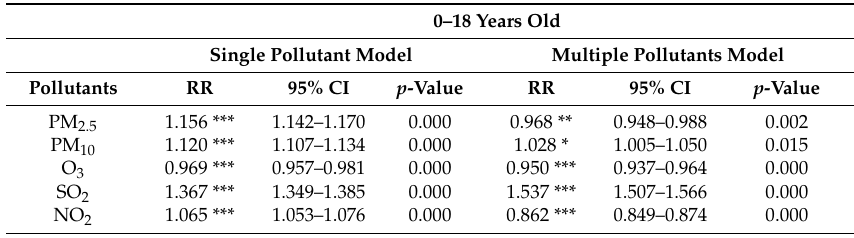
Table 3. Relative risks of asthma hospitalization associated with different air pollutants, single pollutant model vs. multiple pollutants model. CI: confidence interval; RR: relative risk.